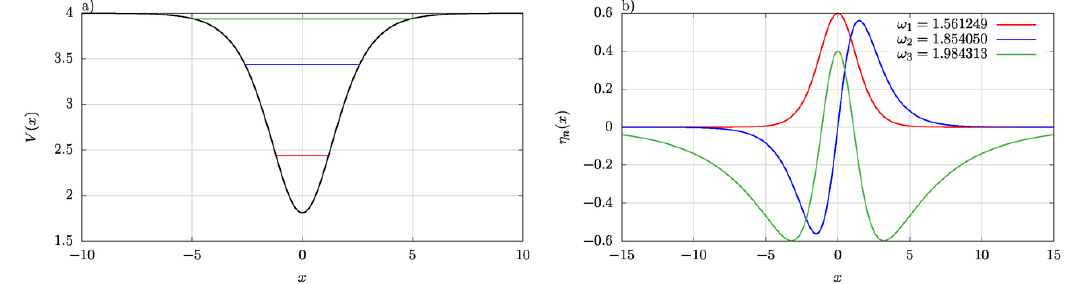
Figure 4 . Example potential (a) and the pro(cid:12)les of the bound states (b) for b = 0 : 5, (cid:21) = 2 : 5 and V 0 = 2 :